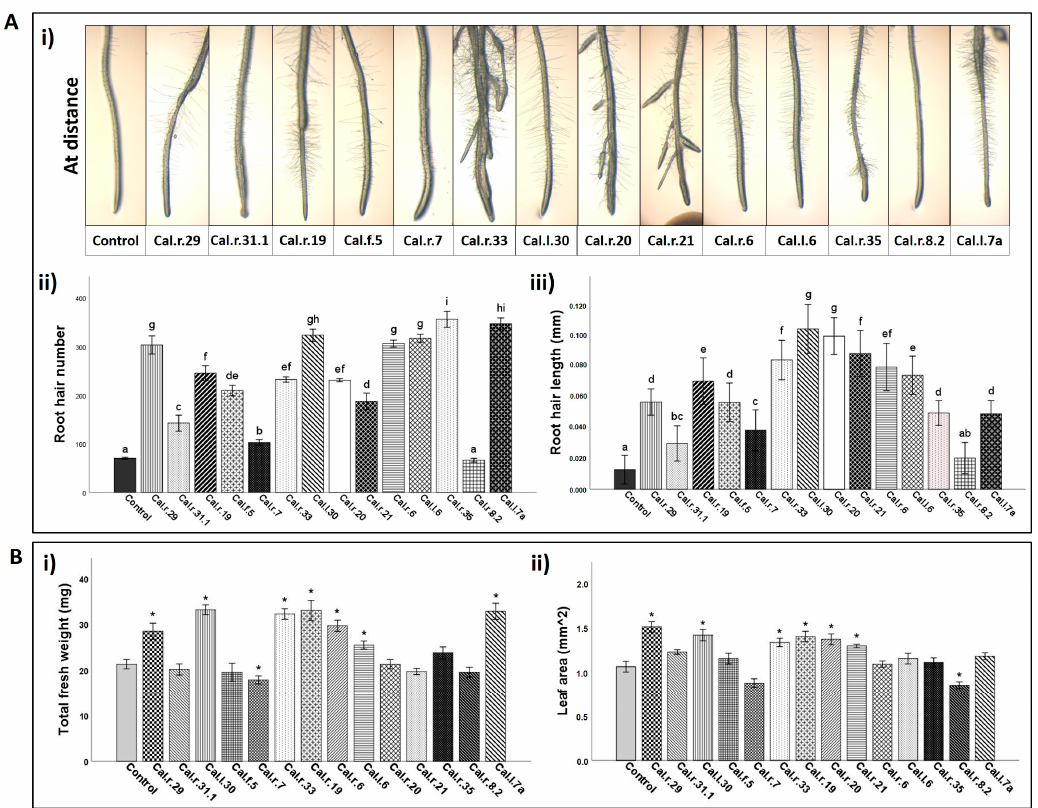
Figure 7. ( A ) Root morphology of A. thaliana seedlings after endophytic bacterial inoculation at- distance from plant root tips. ( i ) Microscopically observed roots; ( ii ) Root hair number (RHN) and ( iii ) root hair length (RHL) after bacterial formulation in comparison to Control plants. Data represent mean values (SD) of 12 seedlings and letters indicate statistically significant differences among treatments, based on Tukey’s test at p = 0.05. ( B ) Co-cultivation of A. thaliana seedlings with endophytic bacterial strains in two compartment Petri dishes (I-plates). ( i ) Total fresh weight (mg) and ( ii ) leaf area (mm 2 ) of A. thaliana seedlings after bacterial inoculation, in comparison to Control plants. Data values represent the mean of 12 seedlings ± SD per treatment. Asterisks indicate the statistical difference between control plants and treated with bacteria plants after Dunnett’s